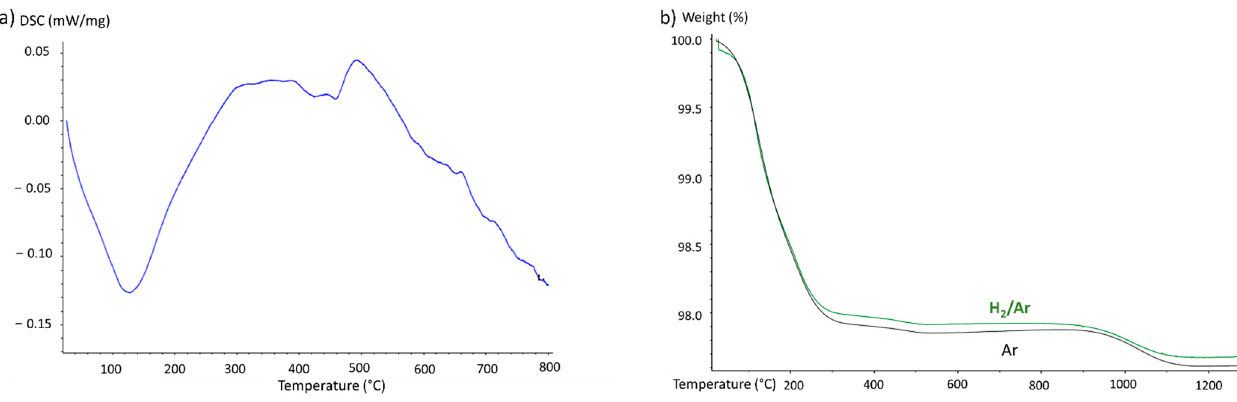
Figure 4. ( a ) DSC analysis of WmoTaNb powder under Ar. ( b ) Thermogravimetric analysis of the milled powder under Ar and Ar/H 2 .